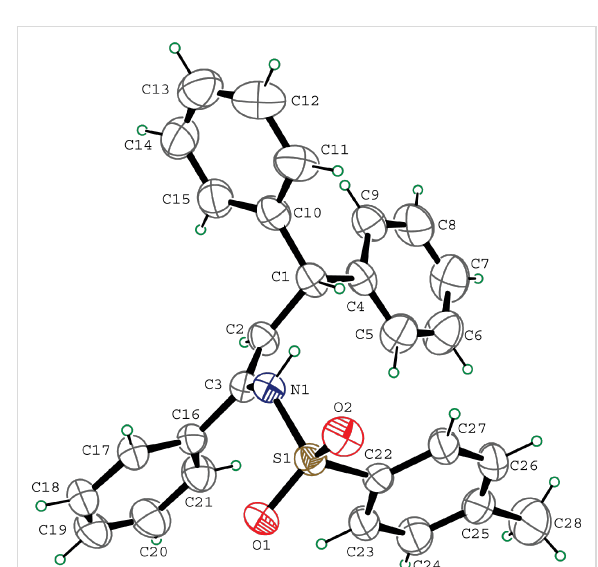
Figure 2: The X-ray structure of 3n .